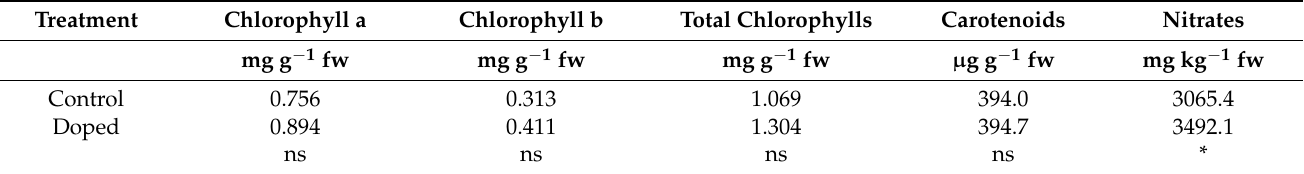
Table 3. Chlorophyll a, b, and total, carotenoids, and nitrate content of the lettuce leaves in greenhouse as affected by the cover